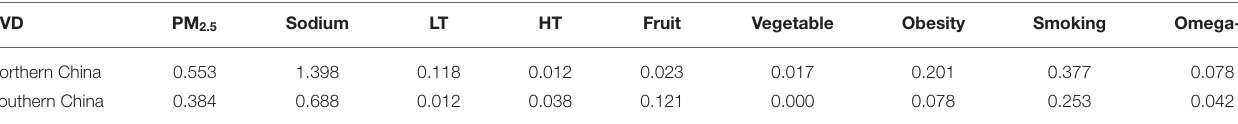
TABLE 5 | Attributable fraction of risk factors for reduced life expectancy caused by CVD (year).